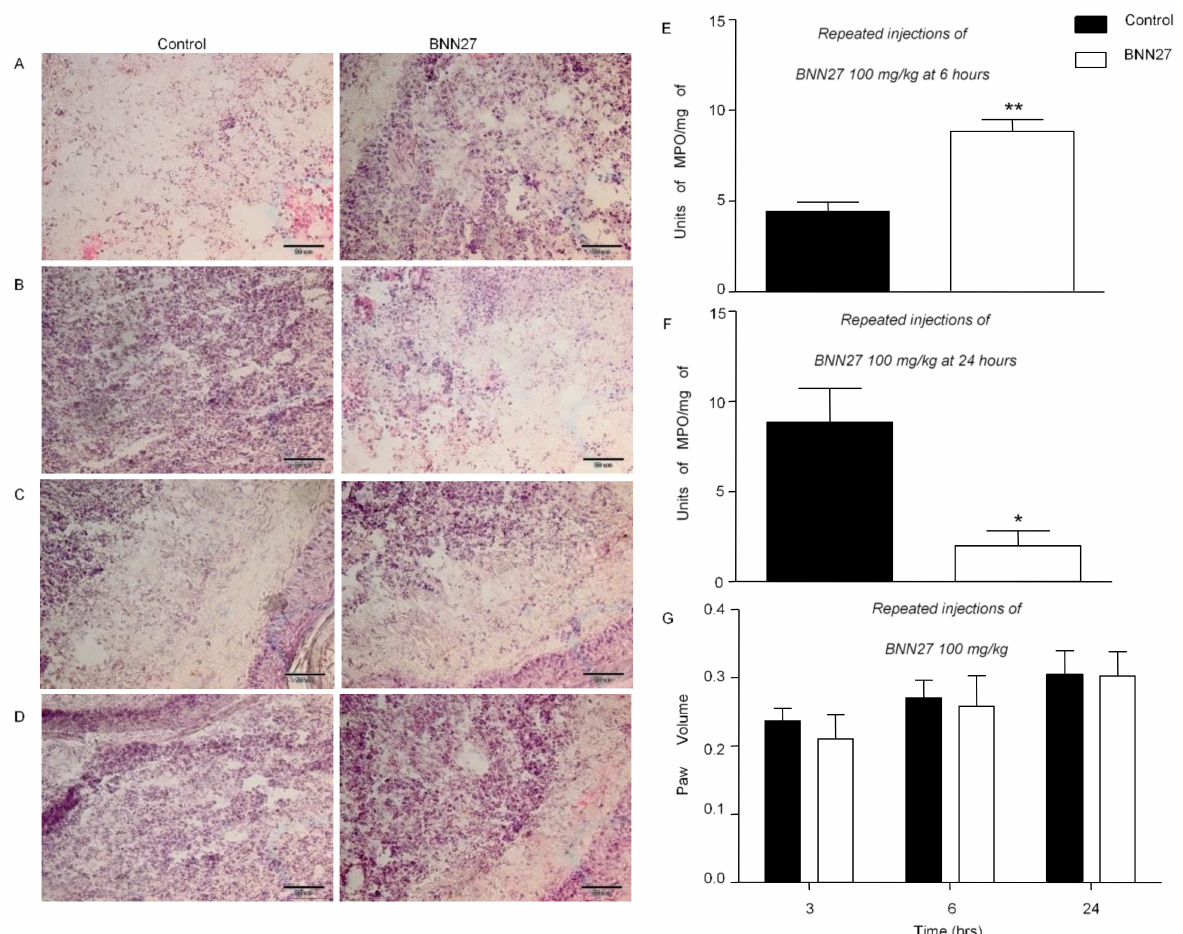
Figure 3. Effect of BNN27 on paw edema and immune cells. Histological examination of the inflamed paw ( A – D ). Leukocyte infiltration in the inflamed paw after repeated injections of BNN27 100 mg/kg at 6 ( A ) and 24 ( B ) hours. Repeated injections of BNN27 10 mg/kg at 3 h ( C ). Single administration of BNN27 100 mg/kg at 3 h ( D ). Following repeated injections of BNN27 100 mg/kg MPO activity is increased at 6 h ( E ), while at 24 h the MPO activity decreases in BNN27-treated mice ( F ). Repeated injections of BNN27 at 100 mg/kg did not alter paw edema ( G ). ( A – D ) Control n = 5 mice, BNN27-treated group n = 5 mice; ( E , F ) Control n = 4 mice, BNN27-treated group n = 4 mice, in both graphs; ( G ) Control n = 9 mice, BNN27-treated group n = 10 mice. In all panels * p < 0.05, ** p < 0.01. Statistical analysis was performed using unpaired t -tests. All data are expressed as the mean ± SEM. Scale bar = 50 µ